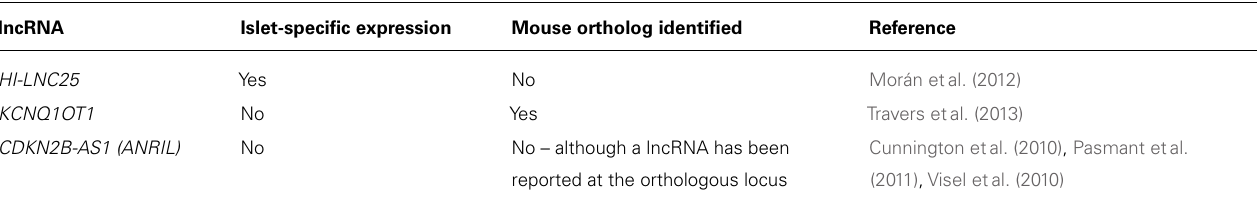
Table 1 |The main lncRNAs discussed in this paper along with their tissue and species